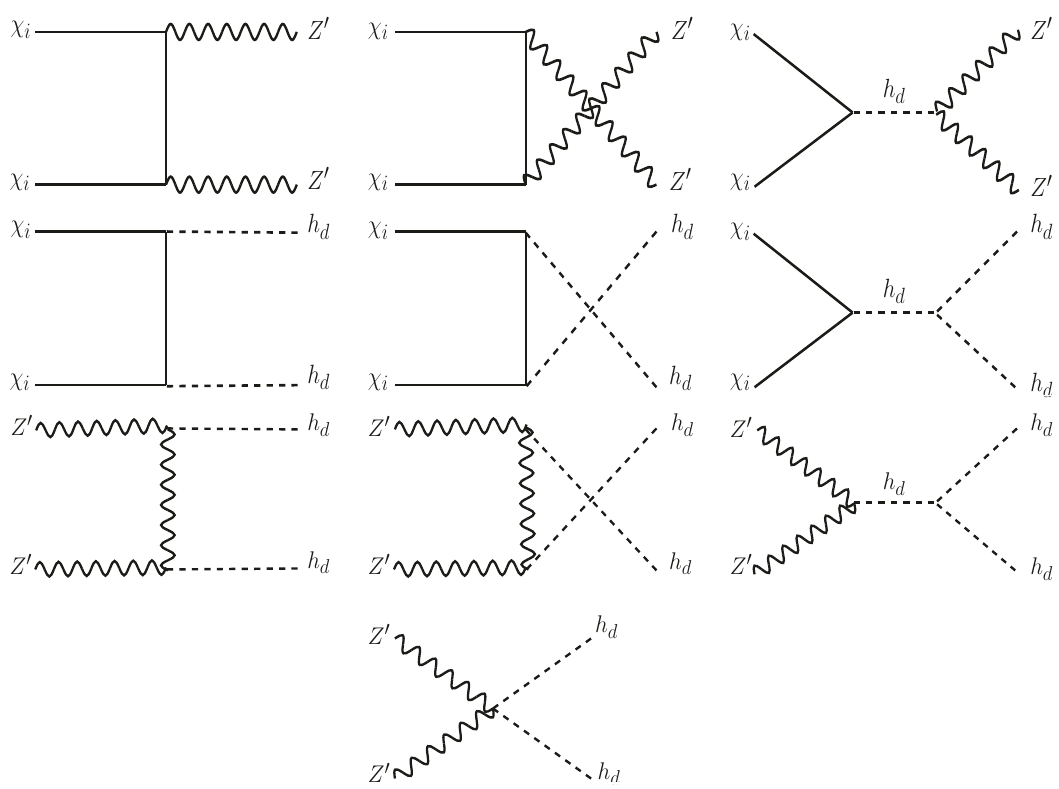
Figure 1 . 2 → 2 annihilation processes significant for the evolutions of temperature and number densities of different species within the dark